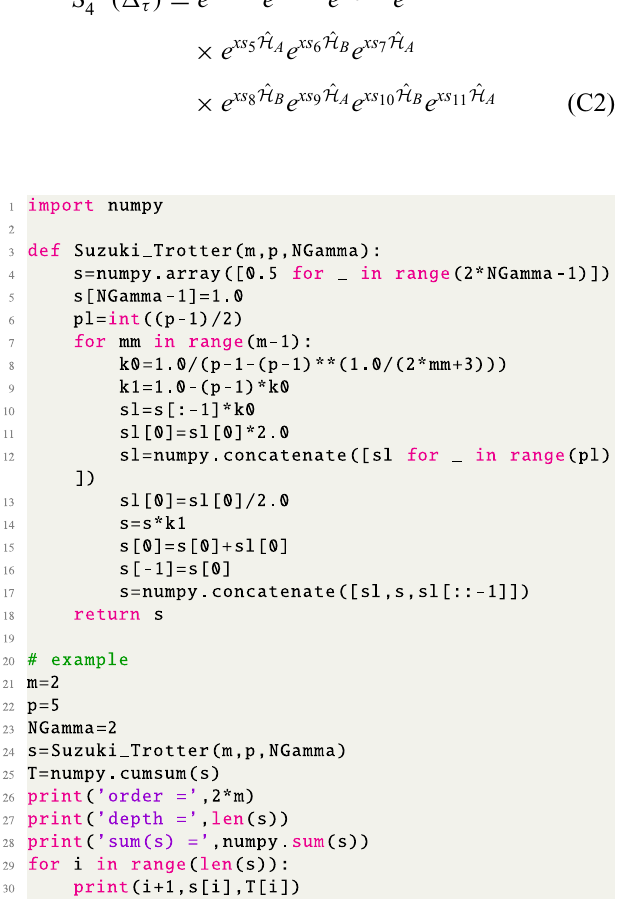
LISTING 1. A PYTHON program for generating the